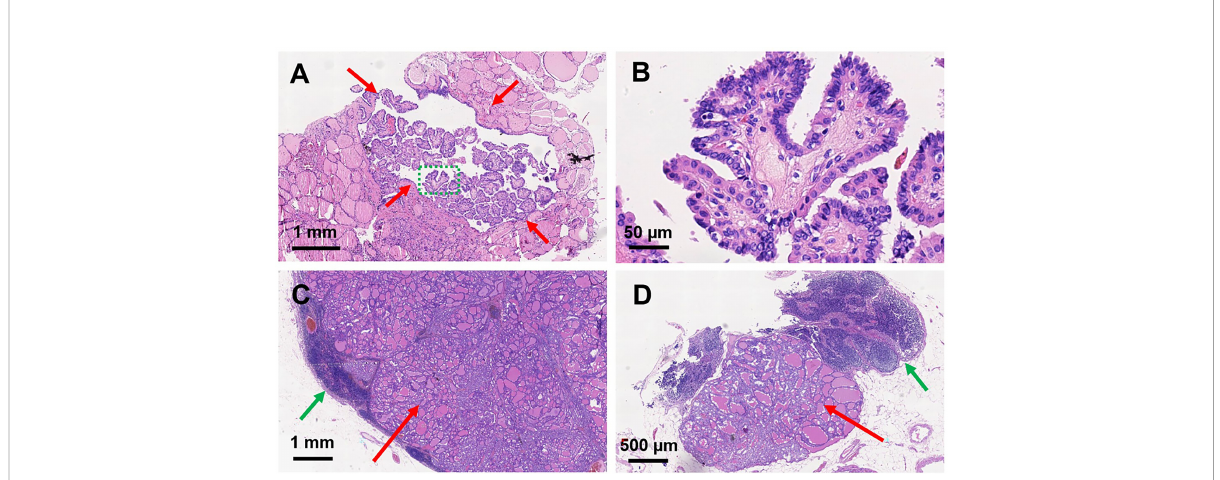
FIGURE 4 Histopathological sections of papillary thyroid microcarcinoma and metastatic lymph nodes. H&E staining of papillary thyroid microcarcinoma in the left thyroid lobe: (A) magni fi cation, × 40; (B) magni fi cation, × 400. Red arrows indicate the PTMC; green dashed circle indicates the ampli fi cation part in (B) . H&E staining of metastatic lymph nodes: (C) magni fi cation, ×16; (D) magni fi cation, ×34. Red arrows indicate the metastatic thyroid tissue in the lymph nodes; green arrows indicate the normal part of the metastatic lymph